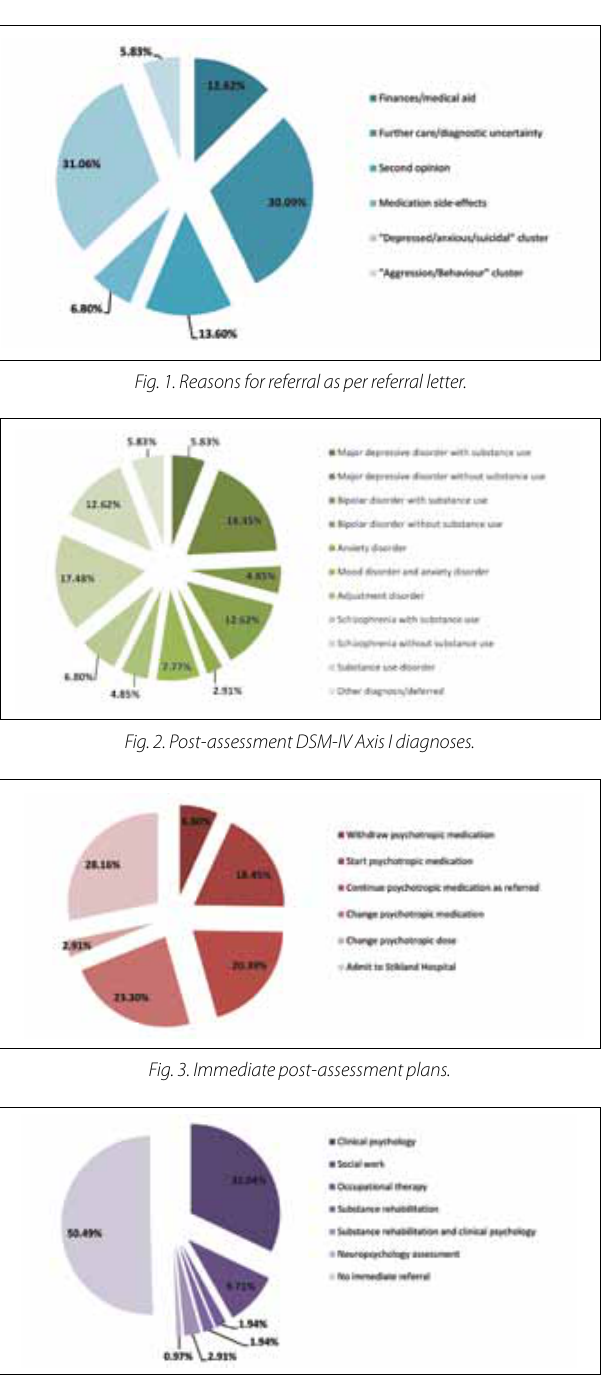
Fig. 4. Immediate post-assessment multidisciplinary